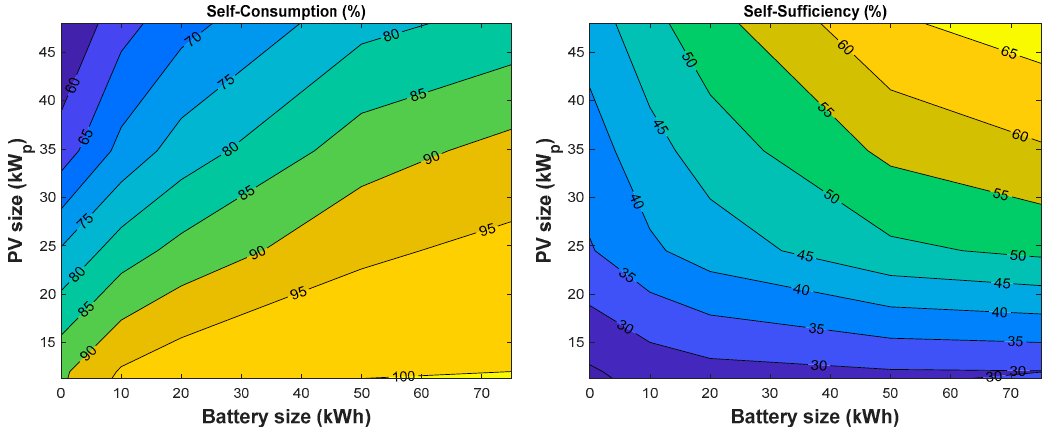
Figure 12. PV and BESS sizing charts based on annual values of S c and S s .